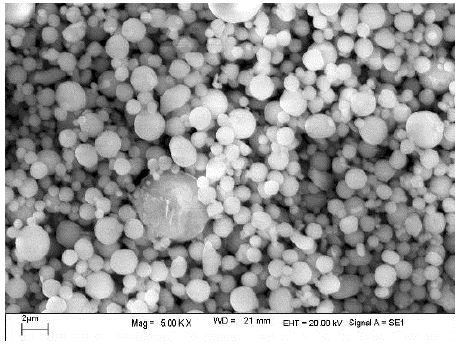
Figure 2. SEM image of the Al powder.